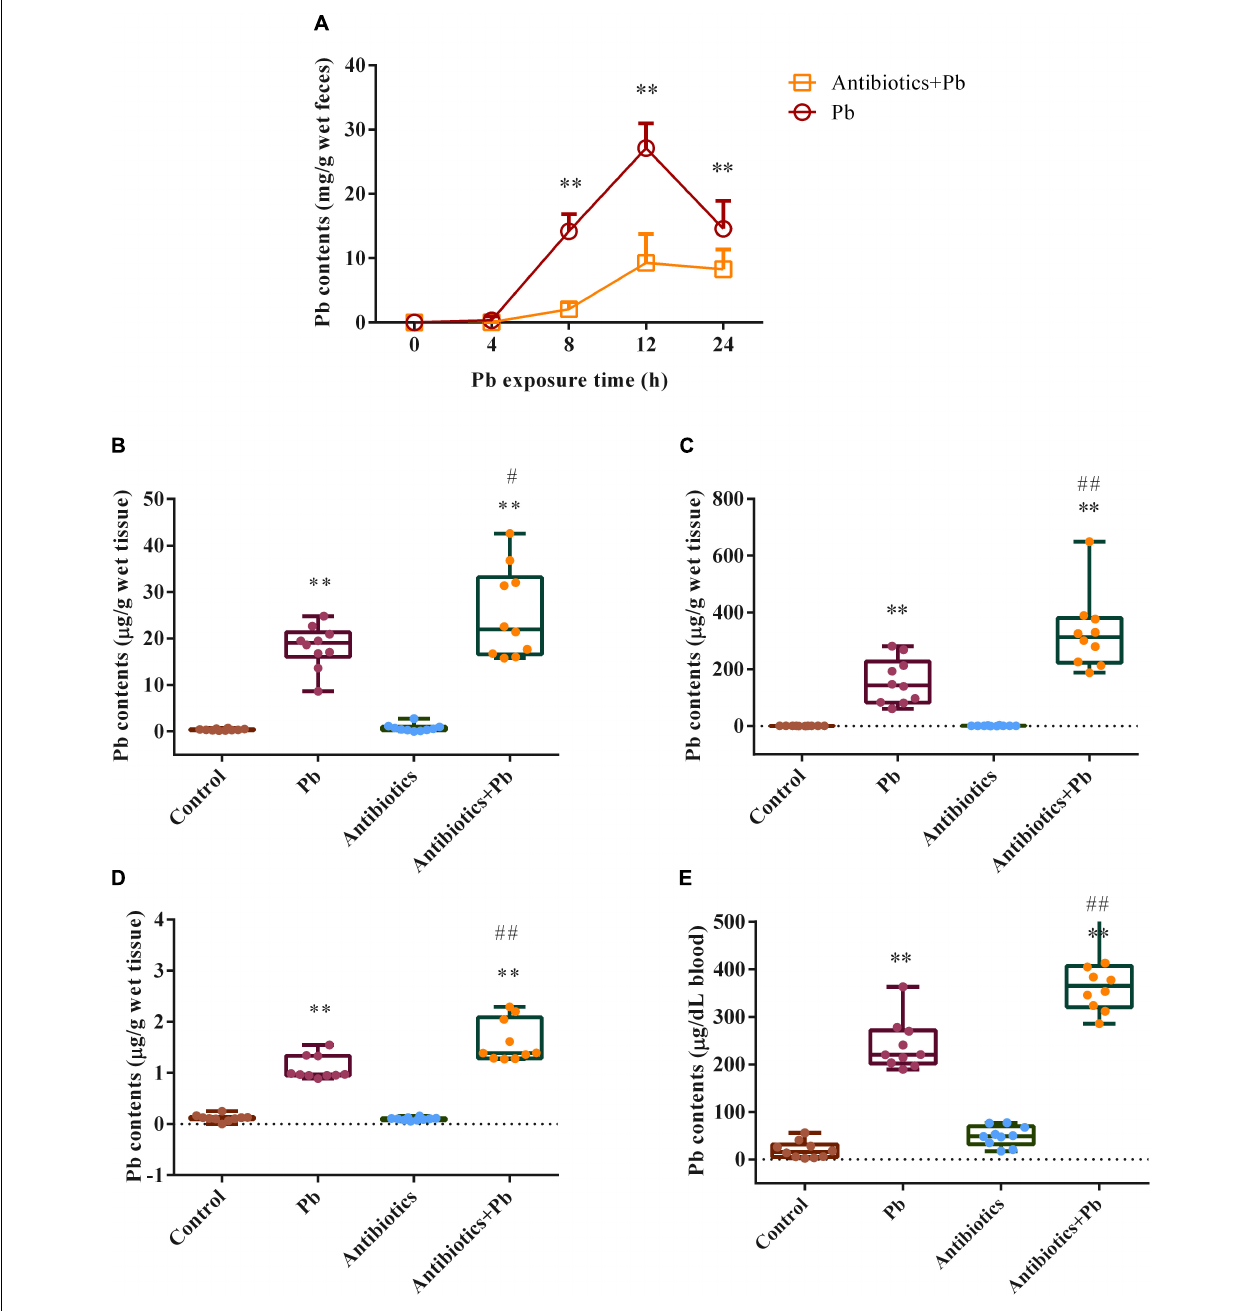
FIGURE 1 | The effects of antibiotic treatment on Pb concentrations in feces, tissues and blood of mice ( n = 10). (A) . Fecal Pb concentrations in the Pb-treated or Antibiotics + Pb-treated mice at different time points. (B–E) . Pb concentrations in the liver (B) , kidneys (C) , brain (D) , and blood (E) of mice. ∗∗ p < 0.01 vs. the control group; ## p < 0.01 and # p < 0.05 vs. the Pb